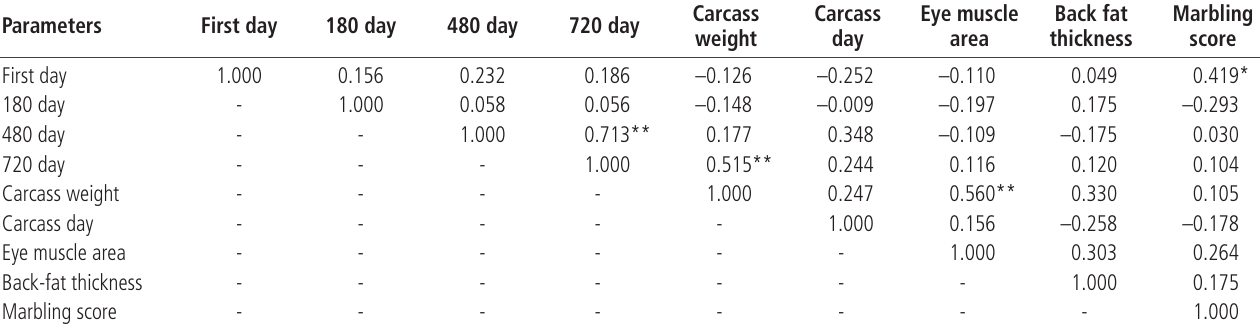
Table 6. Correlation analysis of growth pattern and carcass characteristics of the lowest meat yield group Parameters